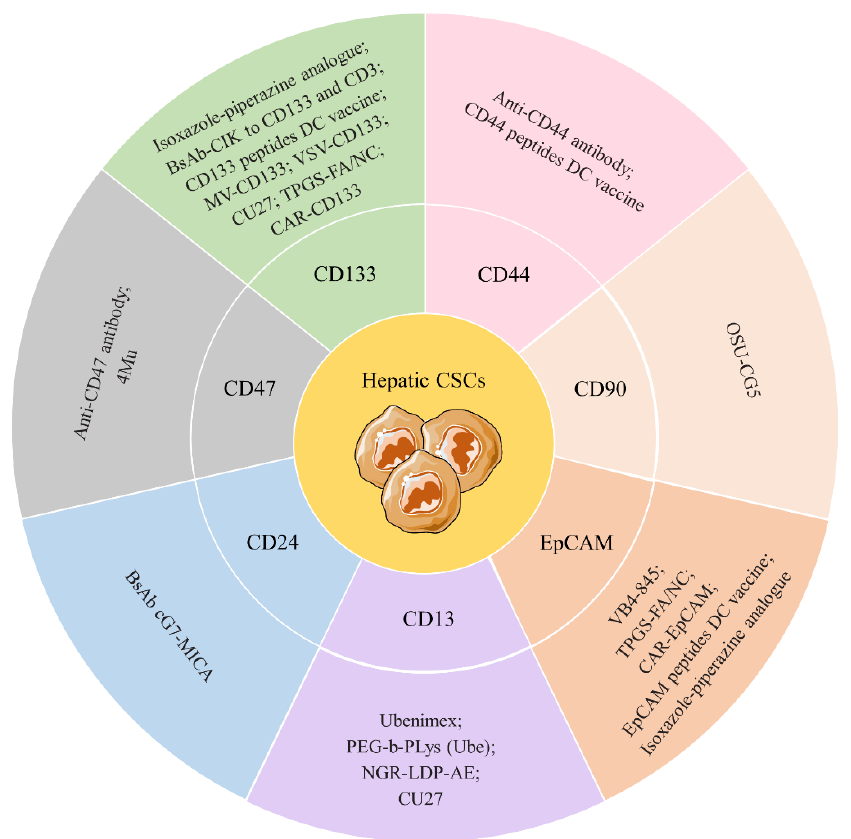
Figure 3. Current therapeutic strategies targeting hepatic CSC surface markers. The seven surface markers in different colored region are the essential stemness markers for hepatic CSCs. Distinct approaches, including oncolytic viruses, inhibitors, antibodies, CAR T cells therapy and vaccines, showed potent inhibitory effects on hepatic CSCs. Combining any of these therapeutic strategies may contribute to the better eradication of CSCs.